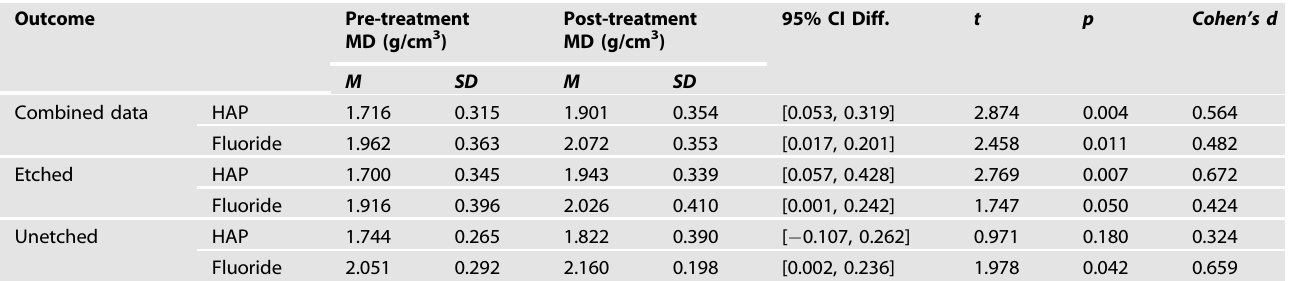
Table 3. Comparing pre-remineralization and post-remineralization mineral density (MD) for hydroxyapatite toothpaste (HAP) and fl uoride toothpaste. Outcome Pre-treatment MD (g/cm 3